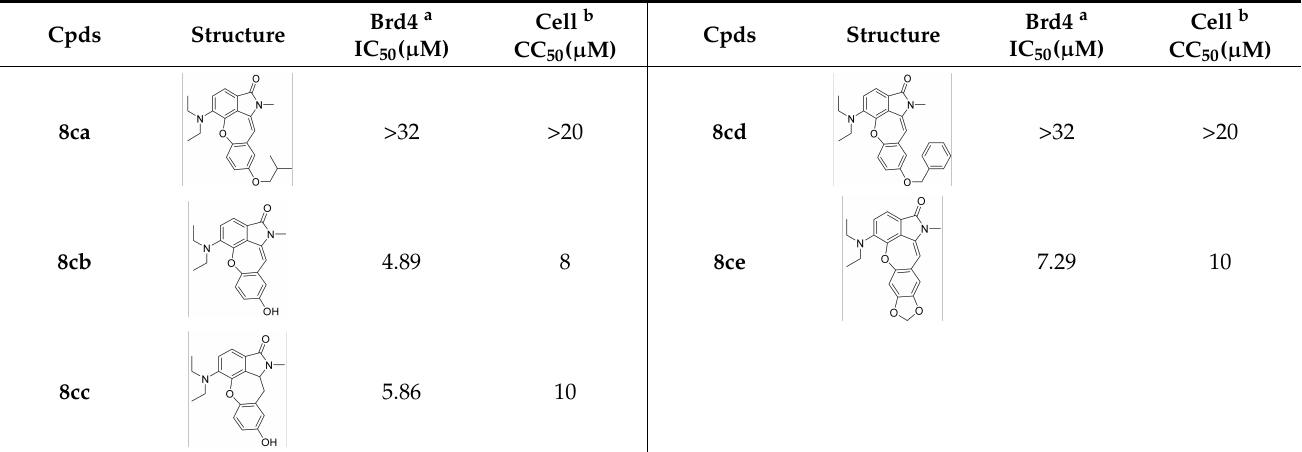
Table 3. Inhibition effects of compounds fixed with diethylamine at R 1 position.